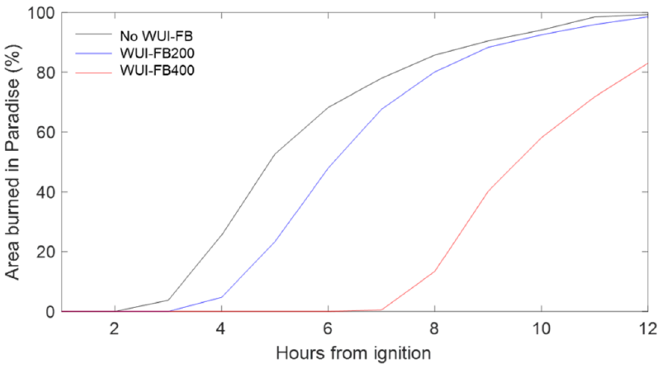
Figure 6. Percent of area burned in Paradise (inside the magenta polygon in Figure 1) vs. time after ignition in hours for the 2018 Camp Fire verification run, 200 m and 400 m WUI fuel break runs.